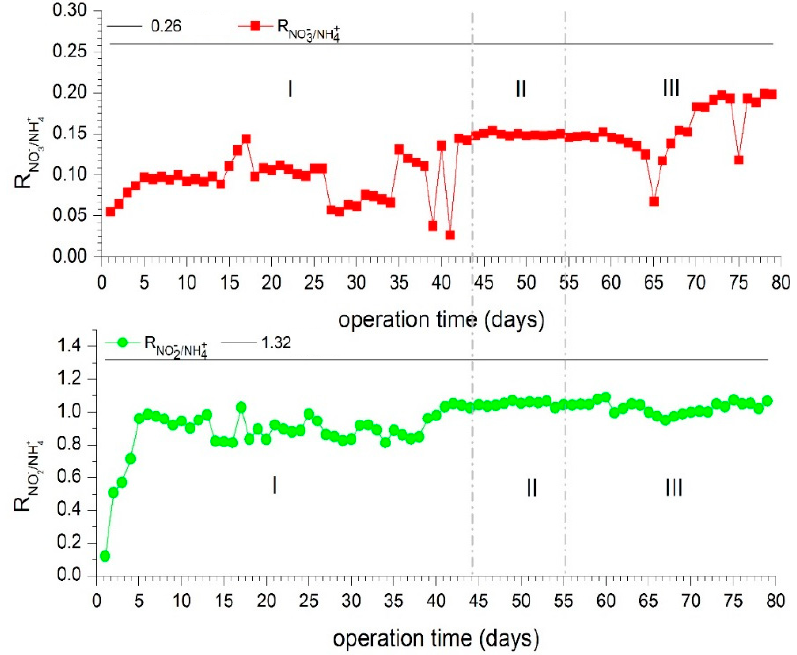
Figure 3. Ratios of nitrite consumption to ammonium consumption (R NO3 − /NH4+ ) and nitrate production to ammonium consumption (R NO3 − /NH4+ ) during the Anammox process.